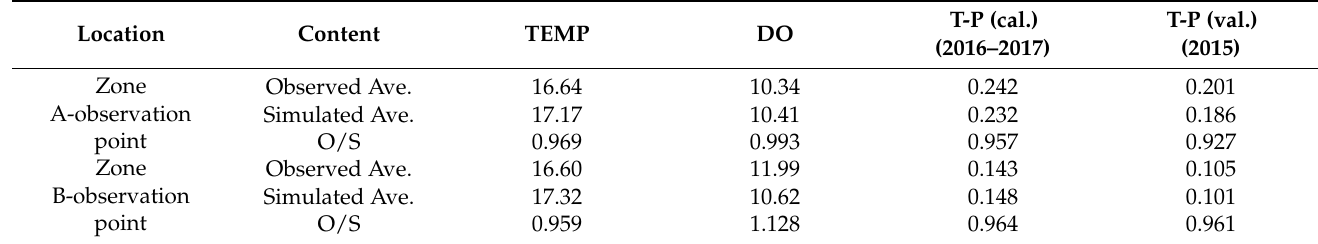
Table 4. Calibration and validation results of EFDC model simulation.